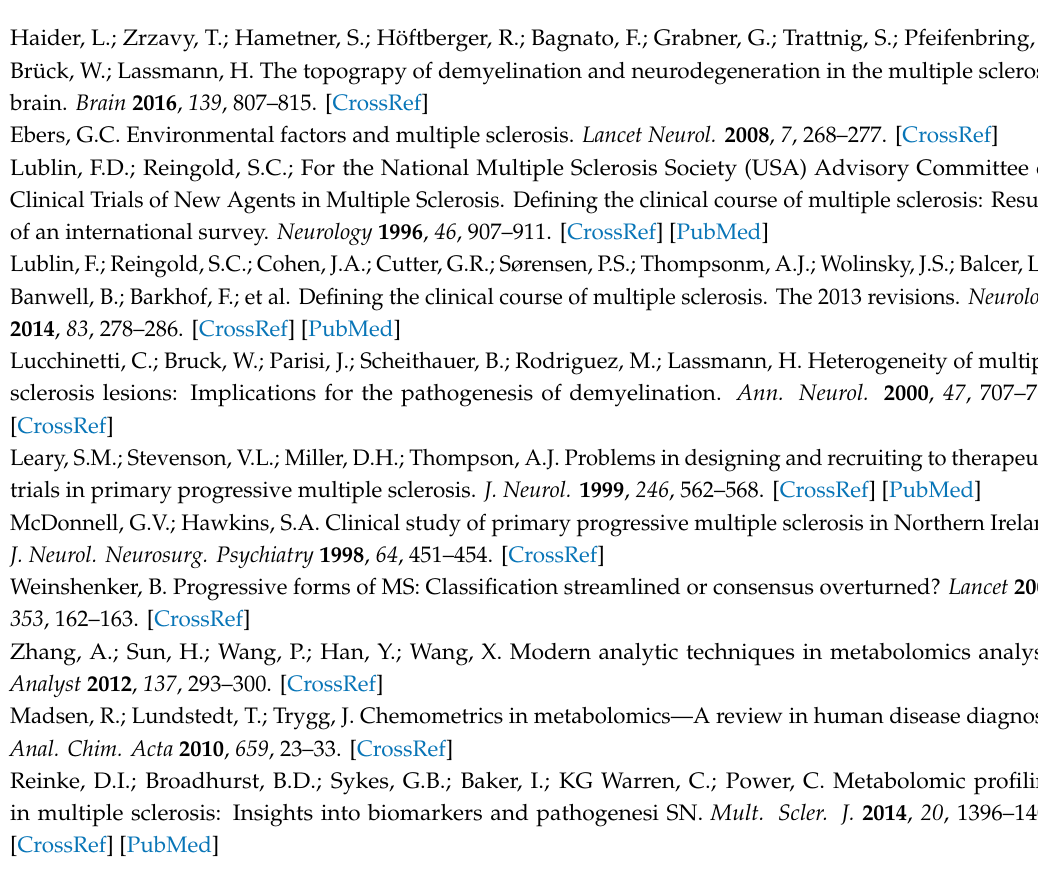
Figure S1: Multivariate analysis of CSF samples and serum samples with NMR and GC-MS. Figure S2: Graphs of the Spearman Correlation of the metabolites of CSF passing the Holm–Bonferroni correction. Figure S3: Graphs of the Spearman Correlation of the metabolites of serum passing the Holm–Bonferroni correction. Table S1: Summary of the analyte abbreviations of Biocrates. Table S2: Statistical parameters of the multivariate models resulting from the analysis of the matrix generated by NMR and GC-MS